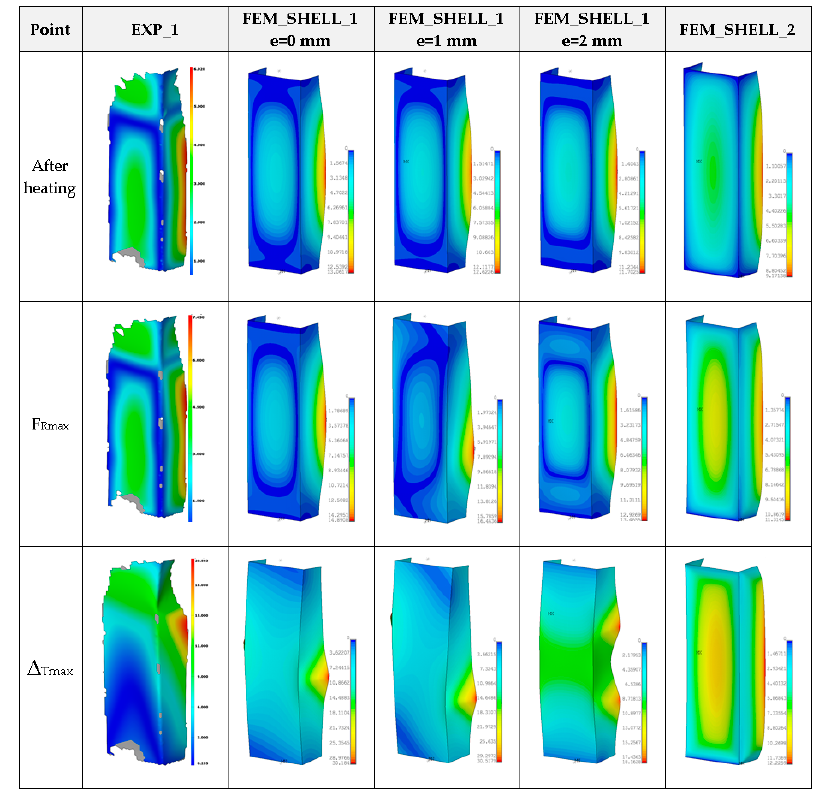
Figure 24. The compression curves of column at 175 °C.